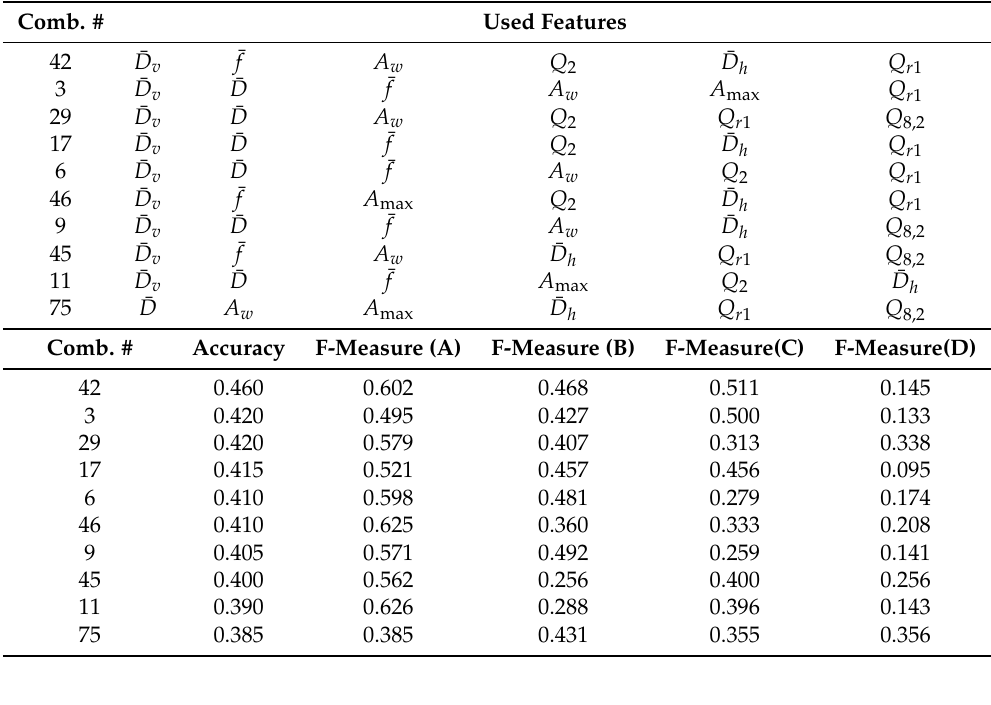
Table 3. Accuracy and F-measures of classes A, B, C, and D for each feature combination in the four-class problem. The list has been sorted in descending order of accuracy.